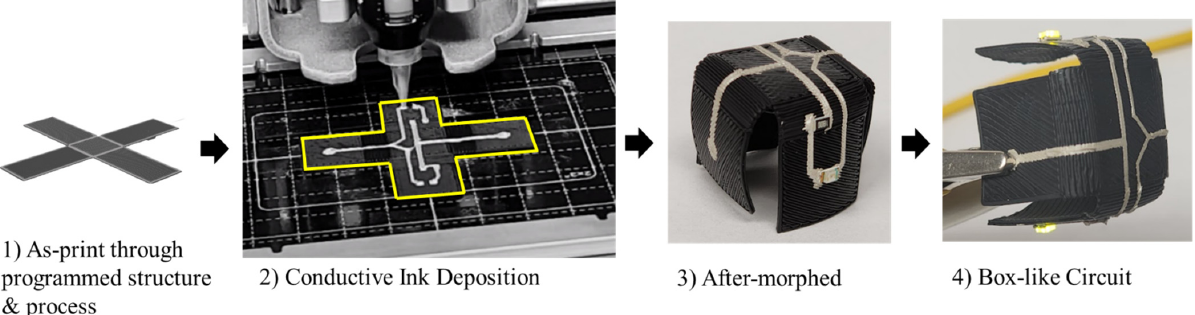
Figure 7. Box-like Circuit Design through the proposed programmable self-morphing method.